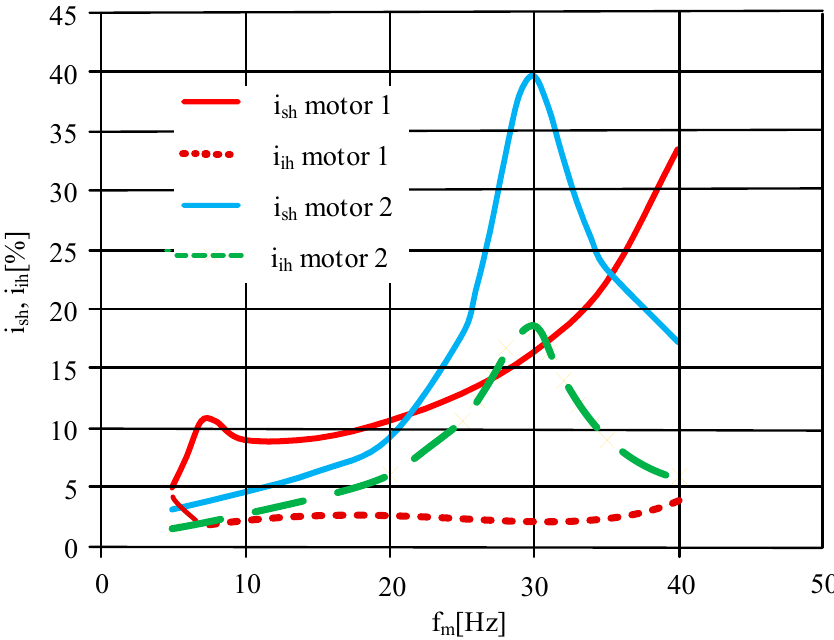
Figure 11. Current subharmonics and interharmonics versus the frequency of voltage fluctuations for the amplitude modulation ( ϕ sh = 0°, ϕ ih = 0°) and the load with a negligible moment of inertia. The frequency components are related to the rated current.